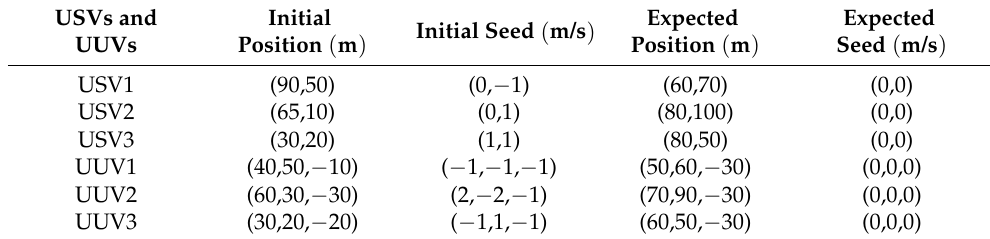
Table 2. Status variables of the USV and UUV.